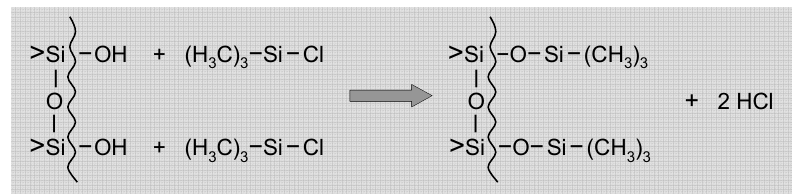
Figure 2. Reaction of surface silanol groups with